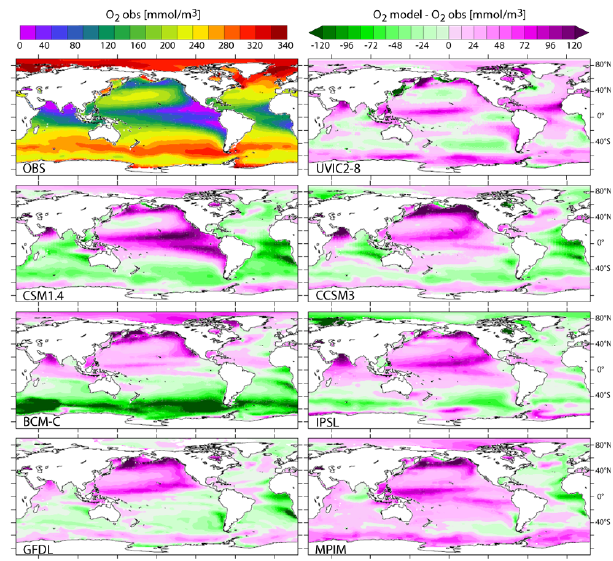
Fig. B1. O 2 in the UML (100–600m depth average). Upper left: O 2 as calculated from WOA 09 dissolved oxygen, temper- ature and salinity. The other panels represent the difference be- tween observation-based estimates and the modeled distributions (1990–1999 mean) of O 2